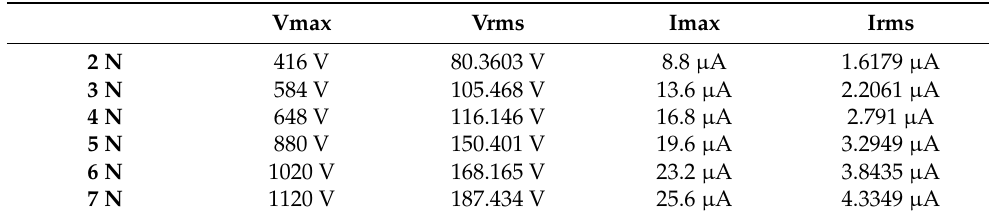
Table 1. Output value from 2 to 7 N of flexible conductive sponge triboelectric nanogenerators (2.8